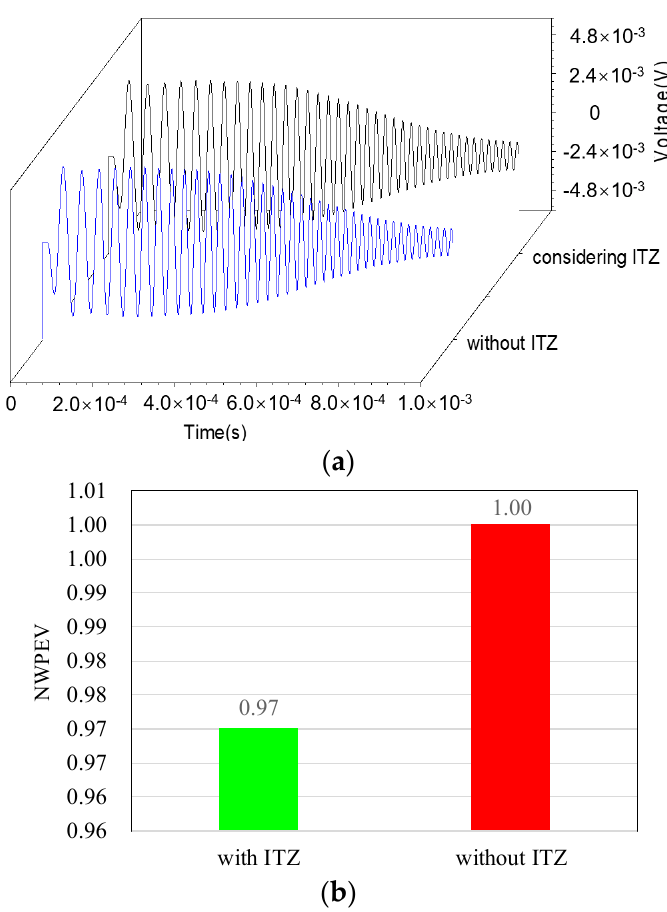
Figure 12. Output voltage and NWPEVs with and without considering ITZ. ( a ) Time–history curves of the output voltage; ( b ) Normalized wavelet packet energy value.